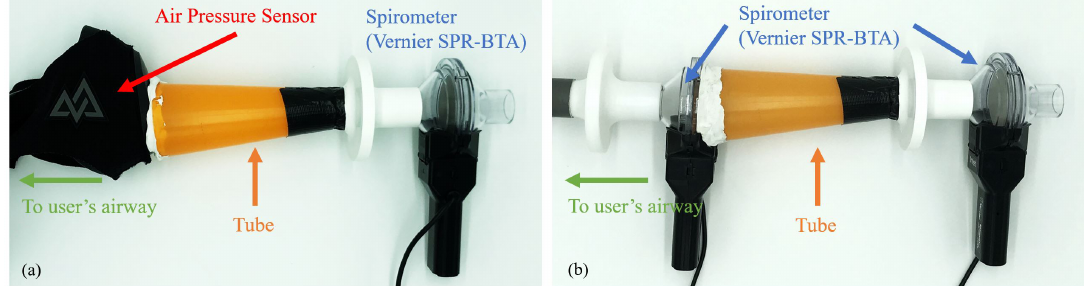
Figure 5. Calibration setup of The BME280 sensor for spirometry: ( a ) M2S setup, ( b ) S2S